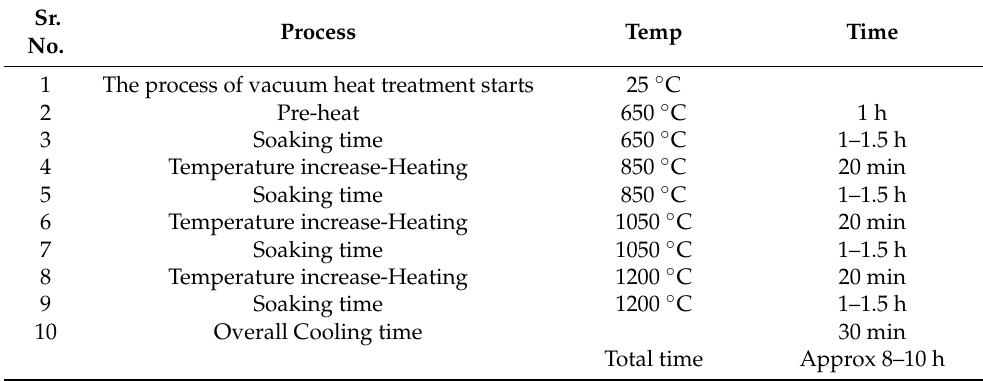
Table 3. The details of the vacuum heat treat cycle .